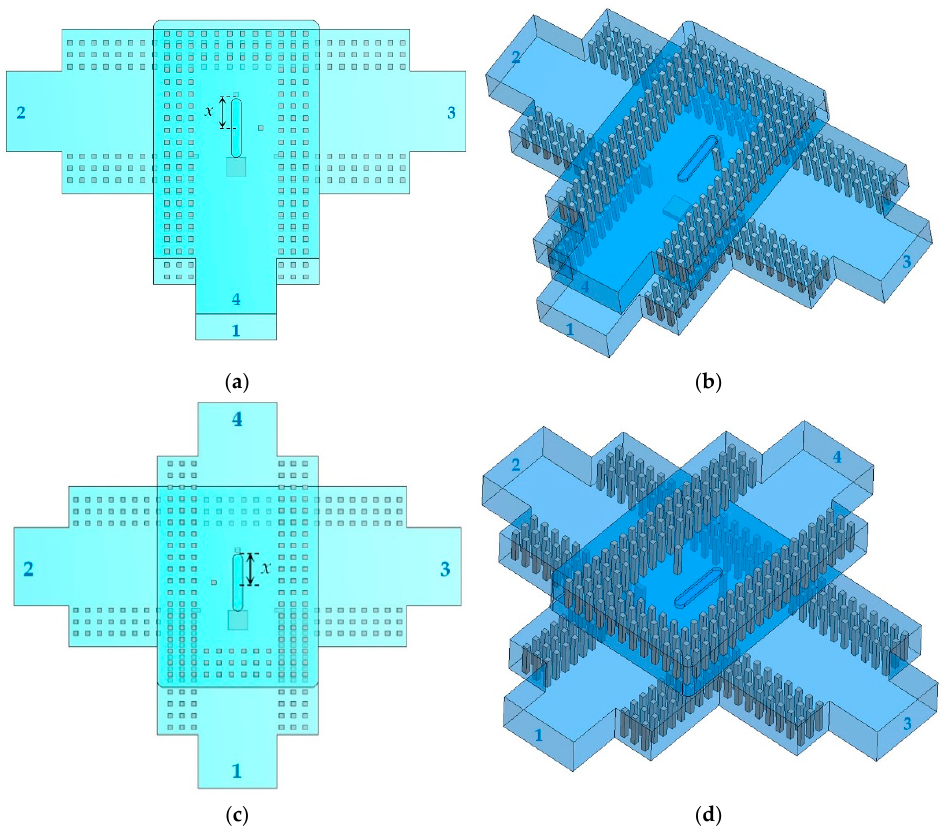
Figure 9. Magic-T geometry. ( a ) TMT top view. ( b ) TMT 3D view. ( c ) XMT top view. ( d ) XMT 3D view.